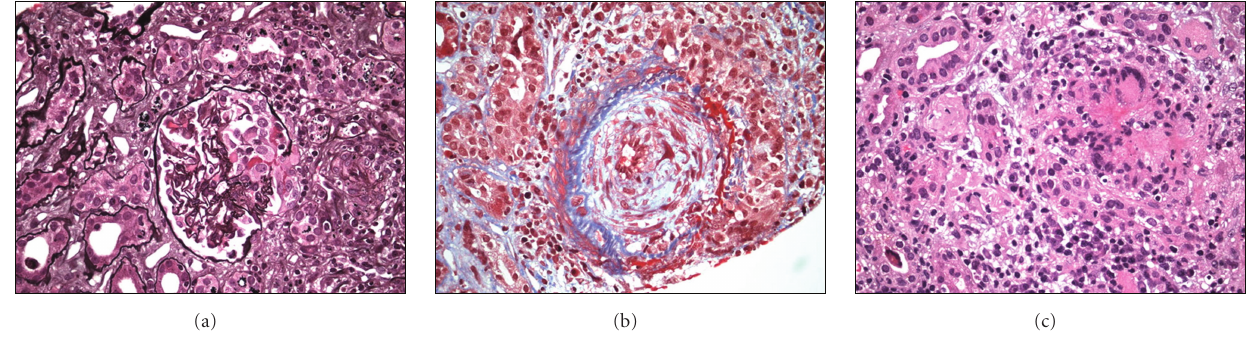
Figure 1: (a) Crescent formation. (b) Granuloma. (c) Vasculitis in medium-sized renal